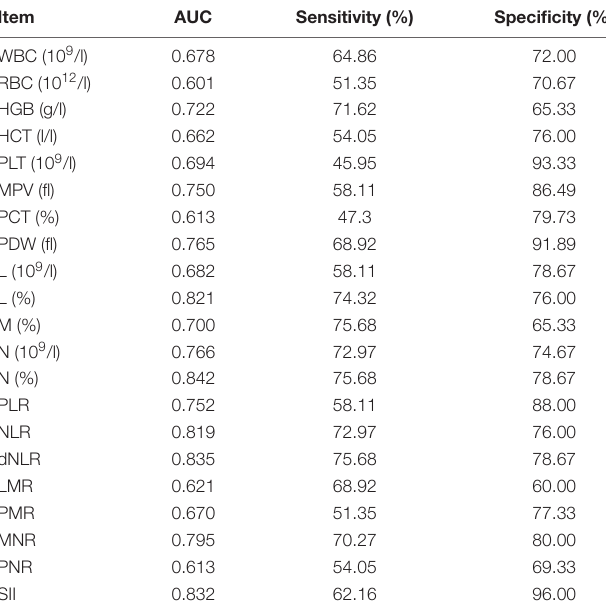
TABLE 4 | The performance of routine indicators.